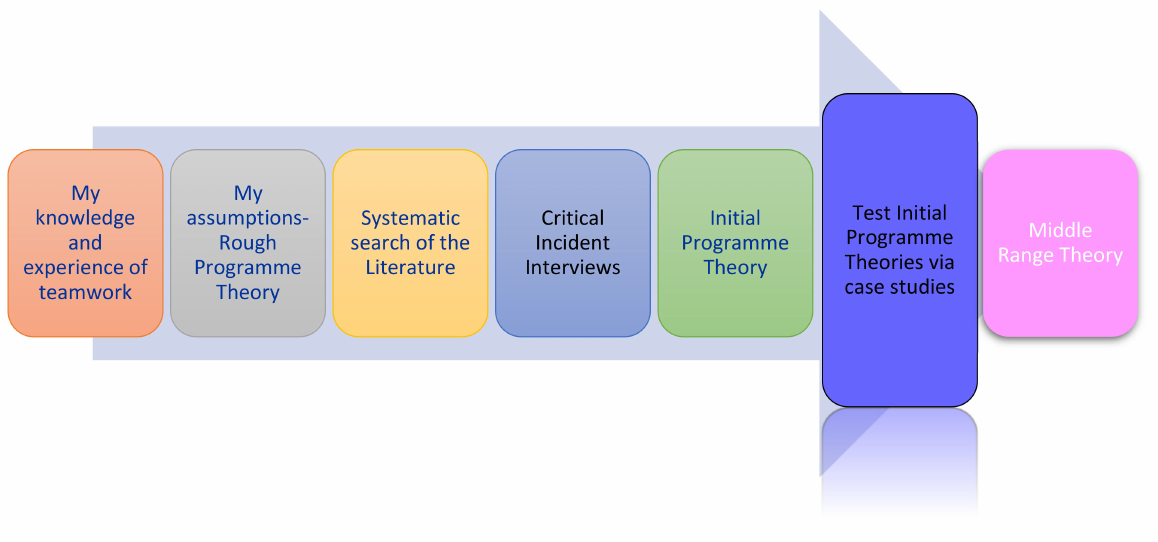
Figure 1. Stages of the realist evaluation [7,8].